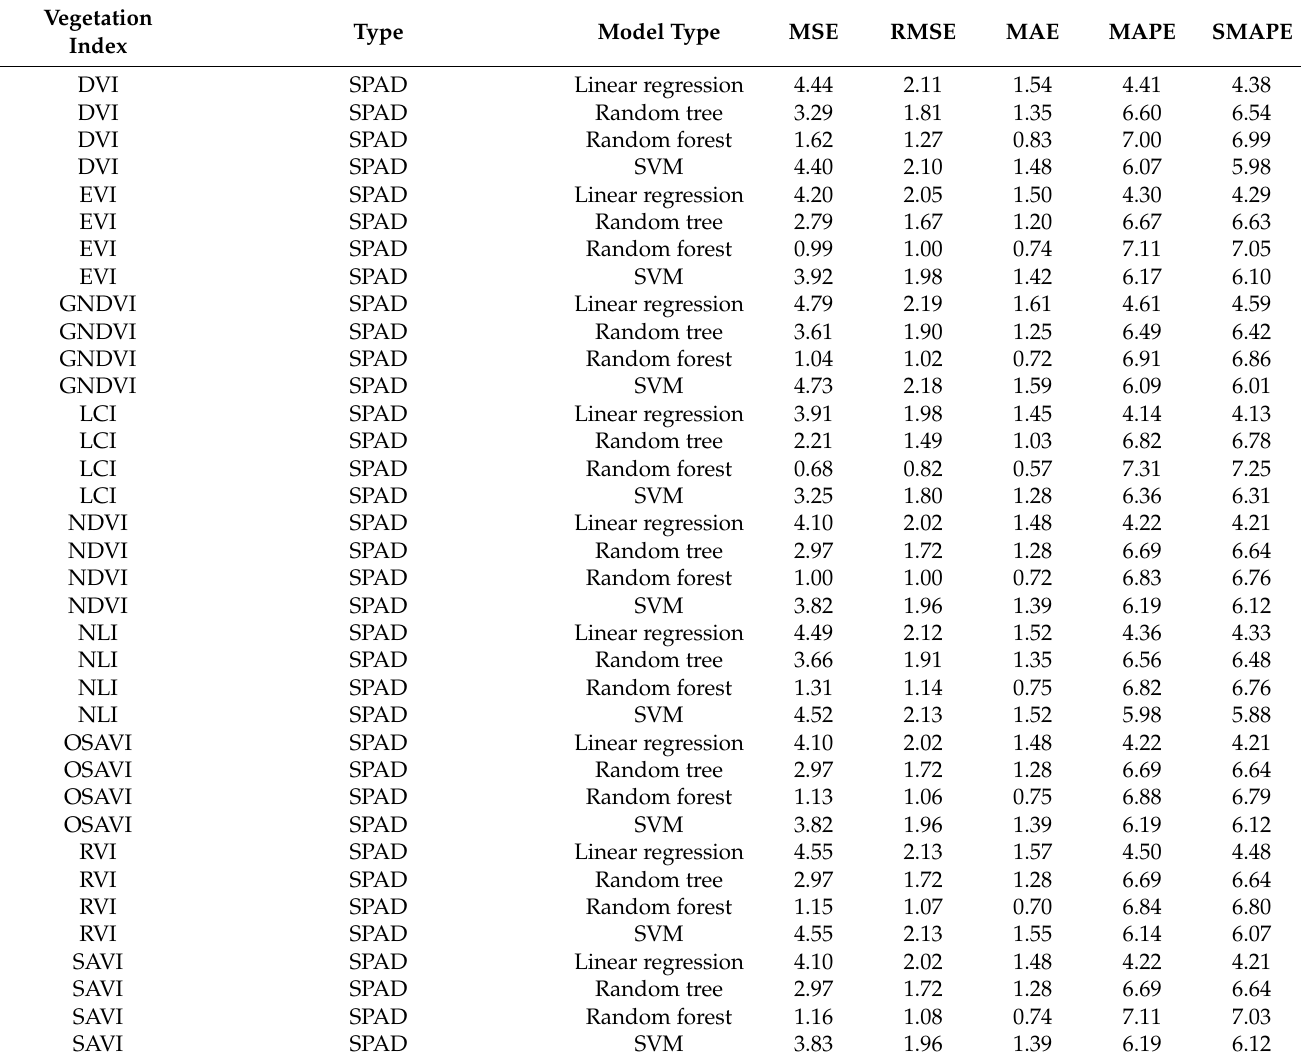
Table A2. Comparison of Prediction Accuracy of Complete Single-Factor Regression